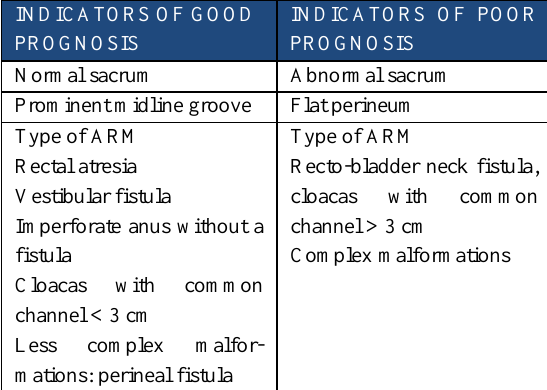
Figure 1: Sketch of anal sphincters. Table 2: Predictors of prognosis in patients with ARM